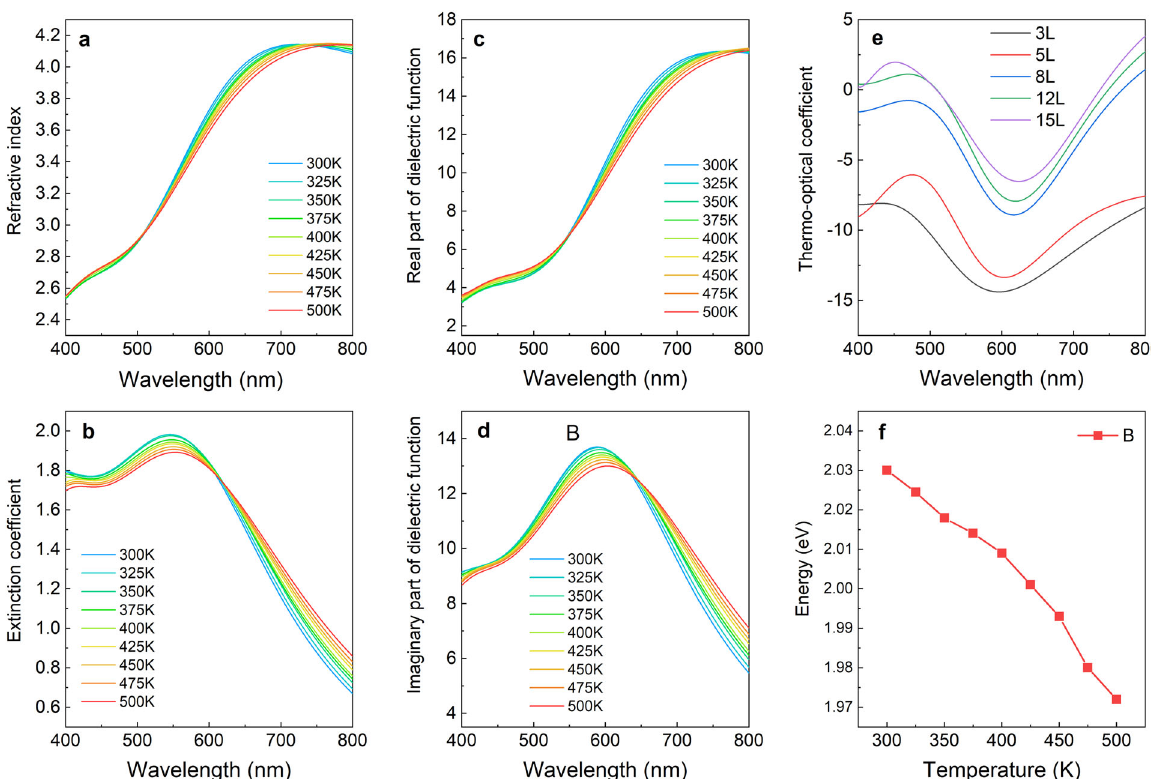
Fig. 5 Temperature-dependent optical and dielectric properties of PdSe 2 fi lms. a – d The refractive index, extinction coef fi cient, real part of the dielectric function, and imaginary part of the dielectric function of the 15L PdSe 2 fi lm, respectively. e Thermo-optical coef fi cients of PdSe 2 fi lms with the different number of layers versus wavelength. f The central energy of the B exciton of 15L PdSe